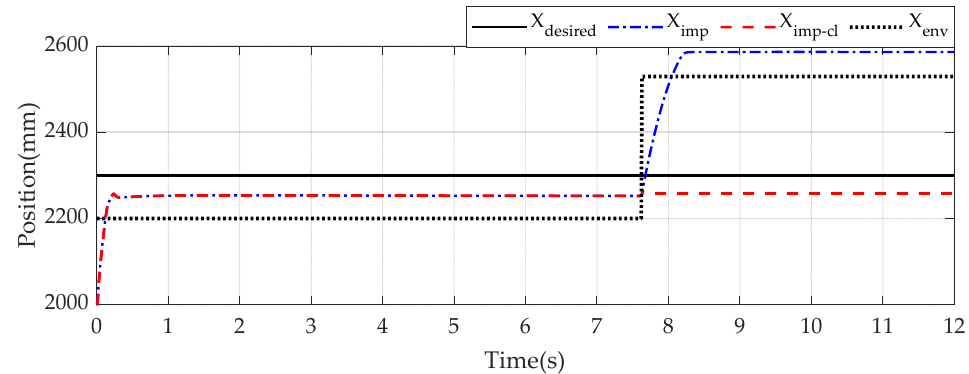
Figure 6. Position response along the X-direction.